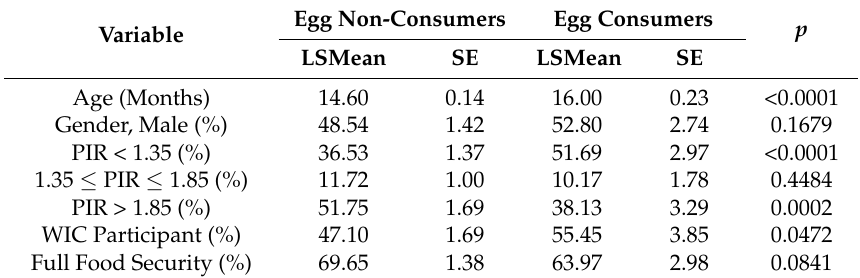
Table 1. Mean demographic variables in egg consumers compared to egg non-consumers.